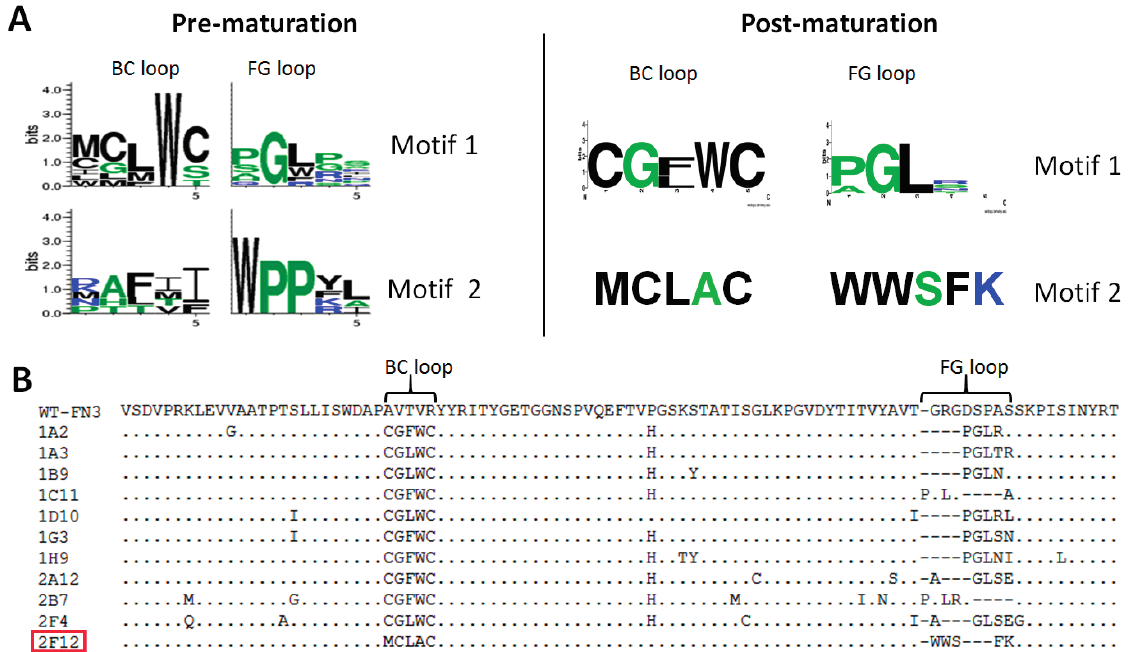
Figure 2. Binding motifs, loop sequences and framework mutations of binders to ubiquitin-conjugating enzyme E2 R1 (CDC34). ( A ) Sequence motifs shared among binders